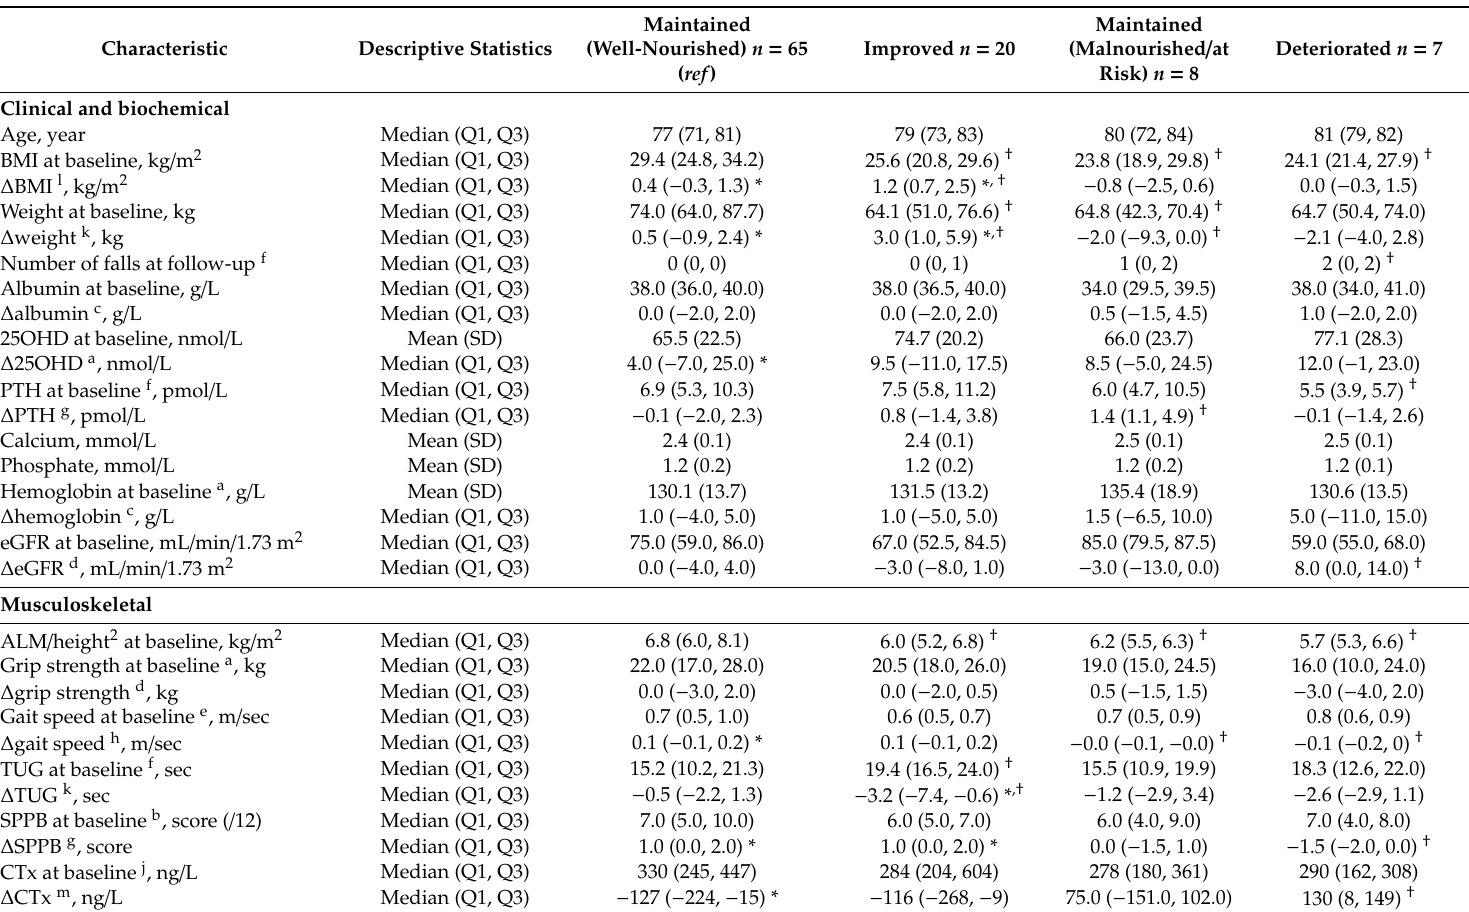
Table 2. Comparison of clinical, biochemical and musculoskeletal measures, stratified by subgroup of nutritional status change.